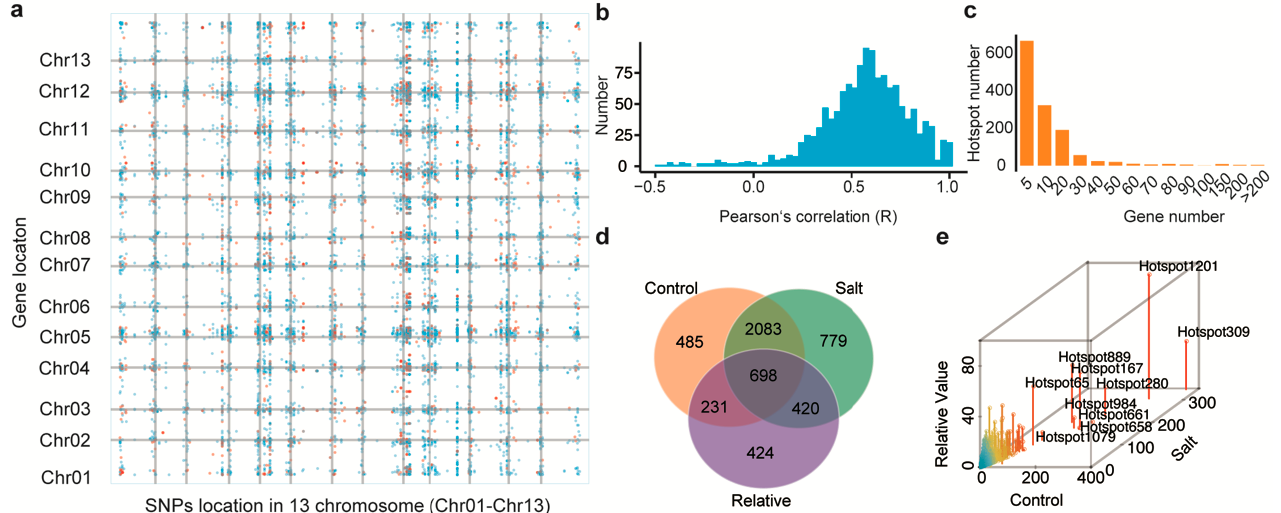
Figure 3. Genomic distribution of trans-eQTLs hotspots. ( a ) Dot plot showing hotspots and their regulated genes on 13 chromosomes. The color of each dot represents the significance ( p -value) of each eQTL-gene association, with log( p -value) > 7 in red and log( p -value) < 7 in blue. ( b ) Distribution of R value means for hotspot genes. ( c ) Distribution of gene number of hotspots. ( d ) Venn diagram showing the overlap of genes significant related to the control, salt, and relative categories. ( e ) Top 10 hotspots in genes related with traits for control, salt, and relative value.